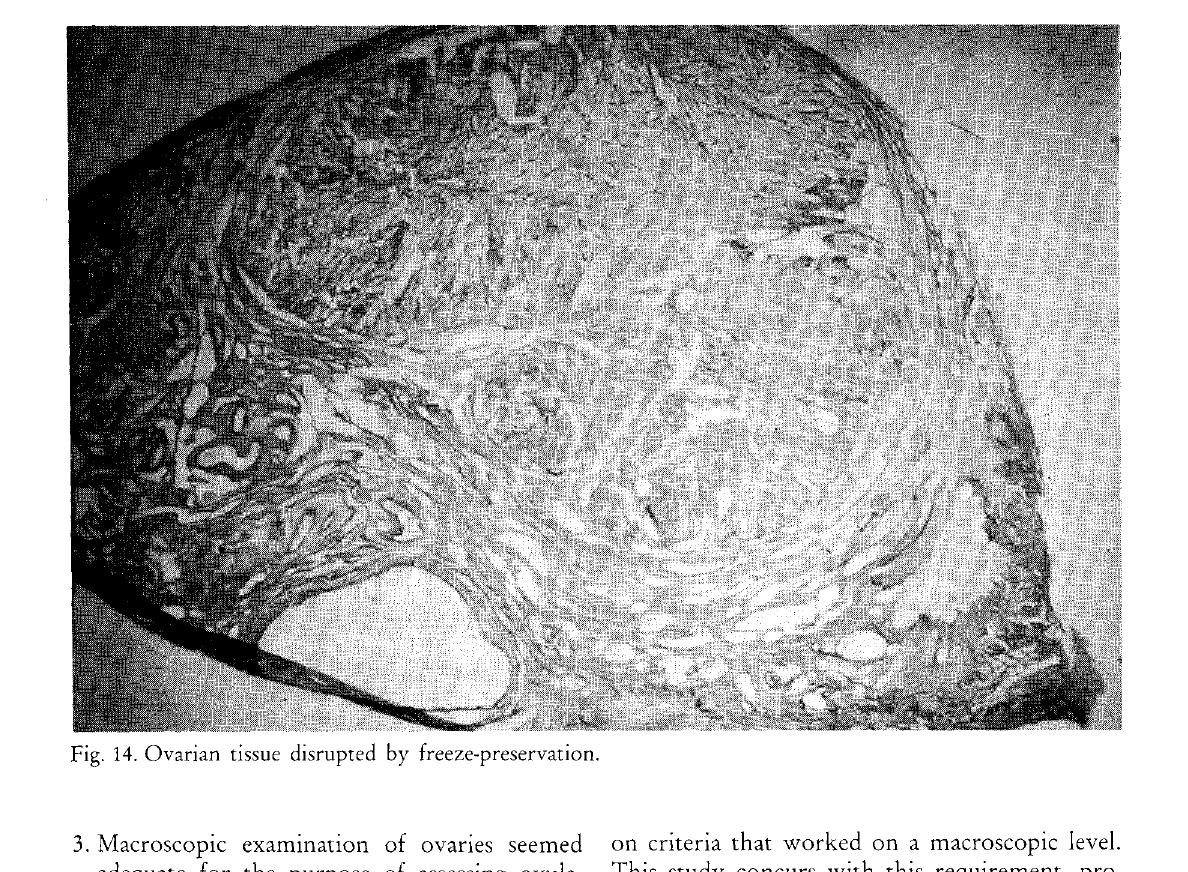
Fig. 14. Ovarian tissue disrupted by